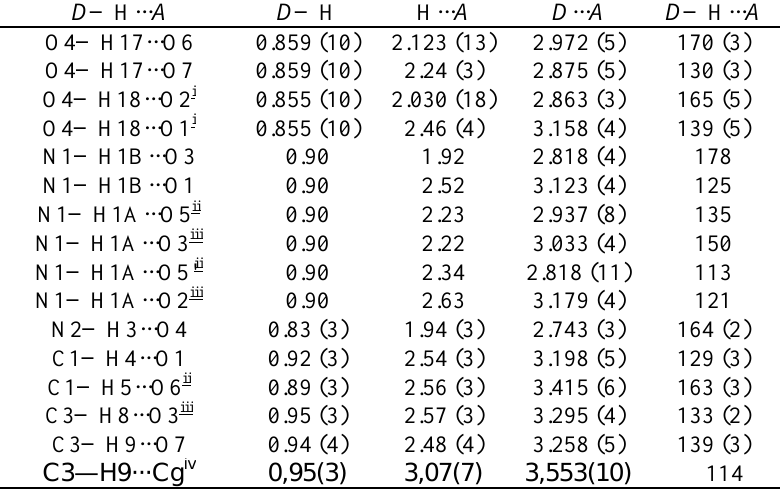
Table 2. Hydrogen-bond geometry (Å,